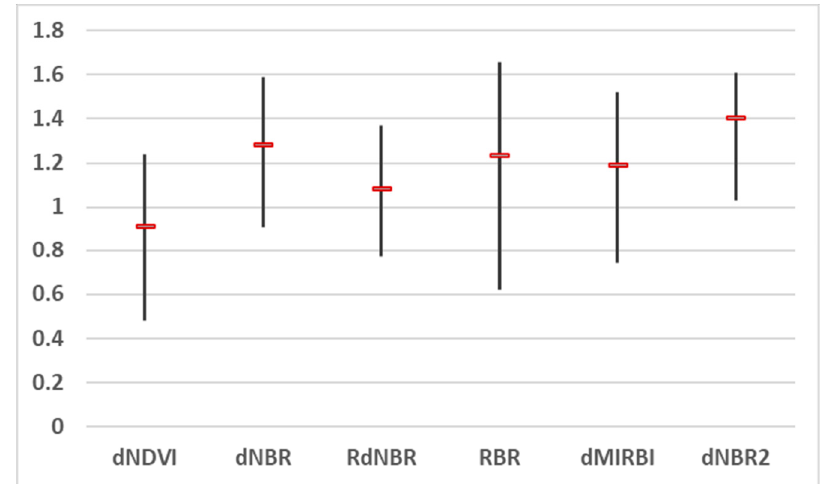
Figure 2. Mean value (red horizontal lines) plus / minus standard deviation of the separability for the multitemporal spectral indices considered in this study.